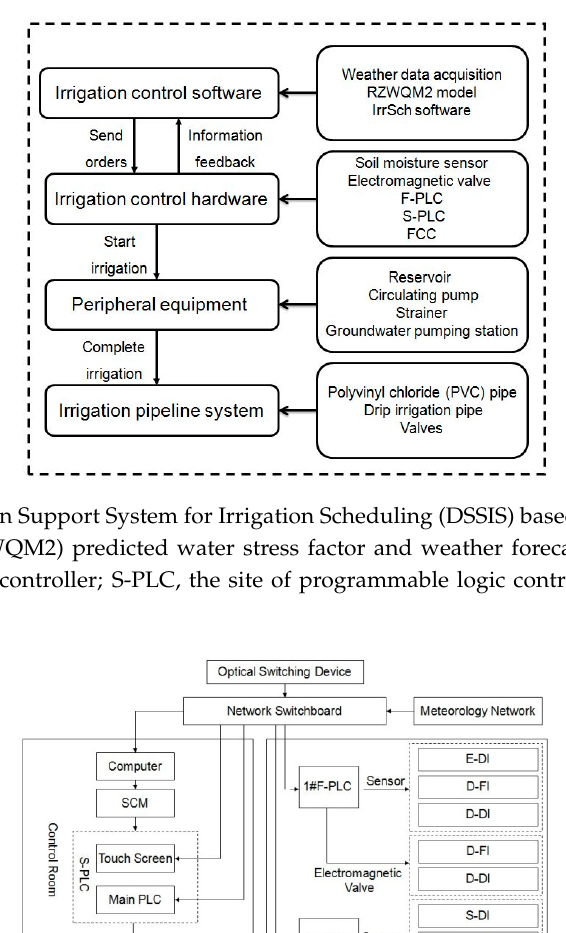
Figure 1. The Decision Support System for Irrigation Scheduling (DSSIS) based on Root Zone Water Quality Model (RZWQM2) predicted water stress factor and weather forecasts. F-PLC, the field programmable logic controller; S-PLC, the site of programmable logic controller; FCC, frequency conversion controller.